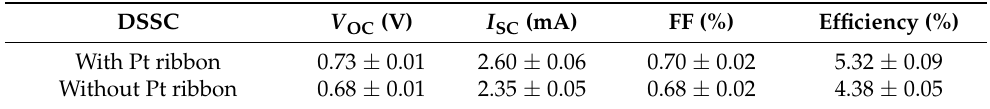
Table 1. Open circuit voltages, short circuit currents, fill factors and photovoltaic efficiencies of DSSCs with and without a Pt ribbon.